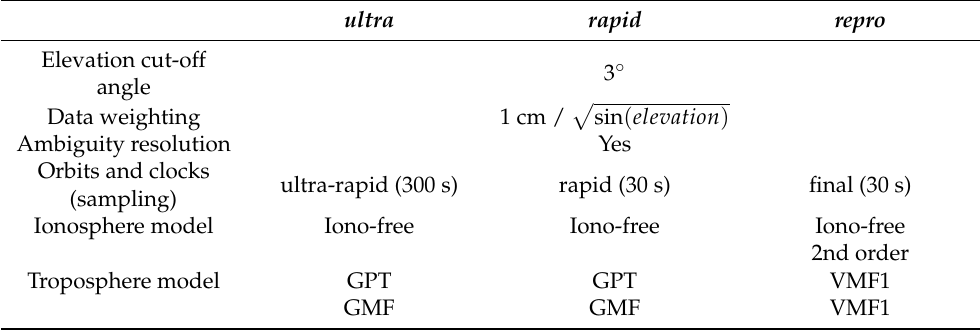
Table 1. GNSS analysis strategies; elevation cut-off angle, data weighting and ambiguity resolution are identical for the three analyses.